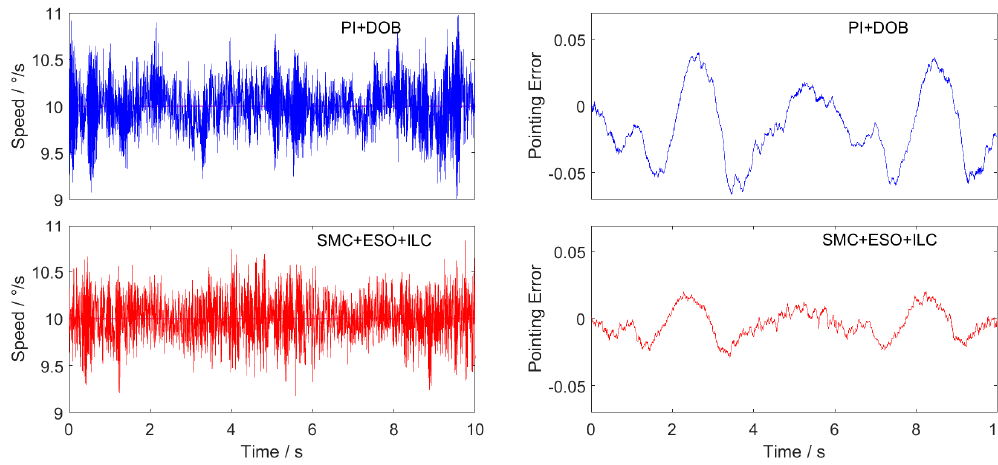
Table 7. Position pointing error of triangular wave tracking.